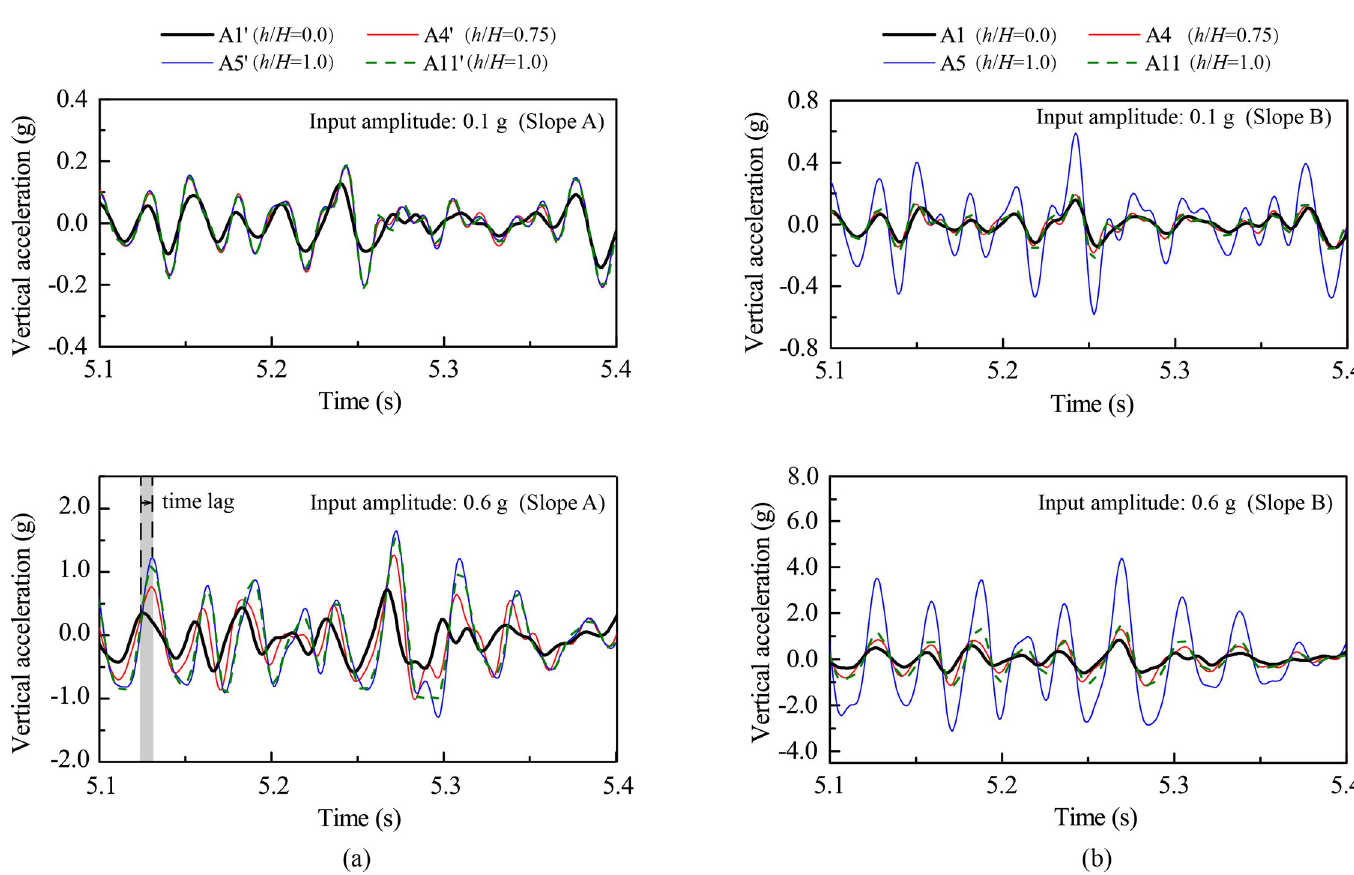
Fig 9. Vertical acceleration responses at selected monitoring points under 0.1 g and 0.6 g levels of vertical shaking: (a) Slope A; (b) Slope B.